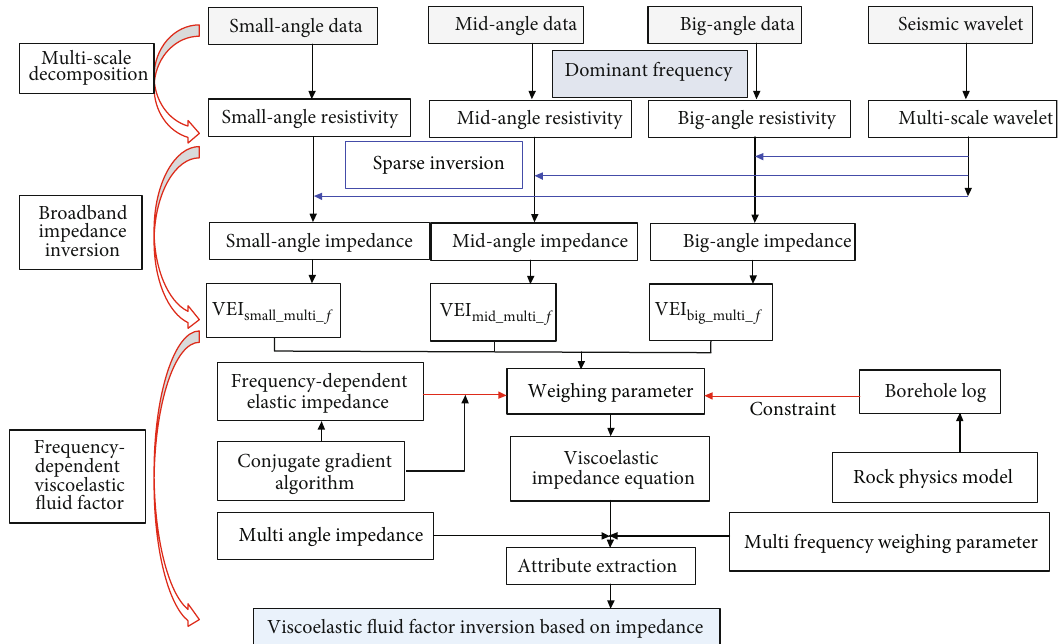
Figure 2: Viscoelastic fl uid factor inversion based on broadband impedance.